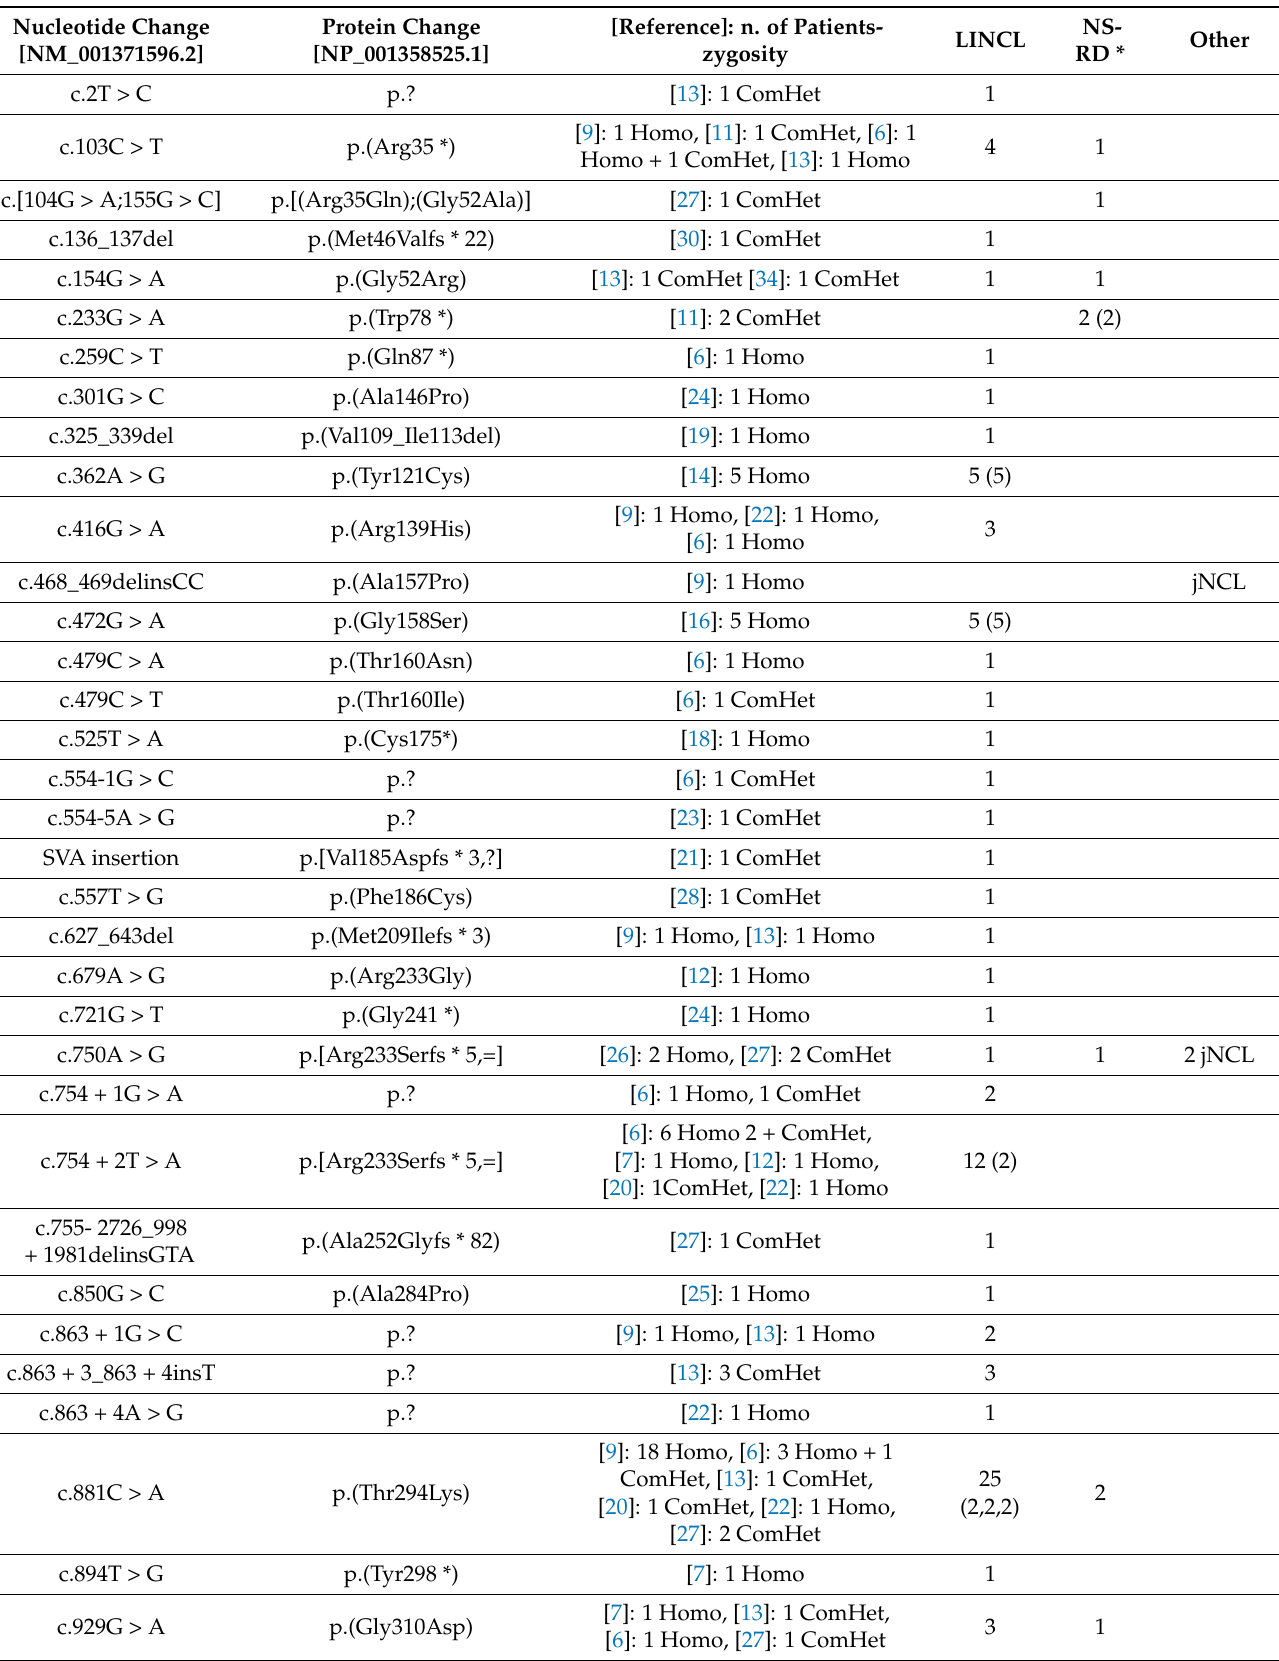
Table 1. Pathogenic MFSD8 variants reported in the scientific literature (CLN7 and NSRD). Nucleotide